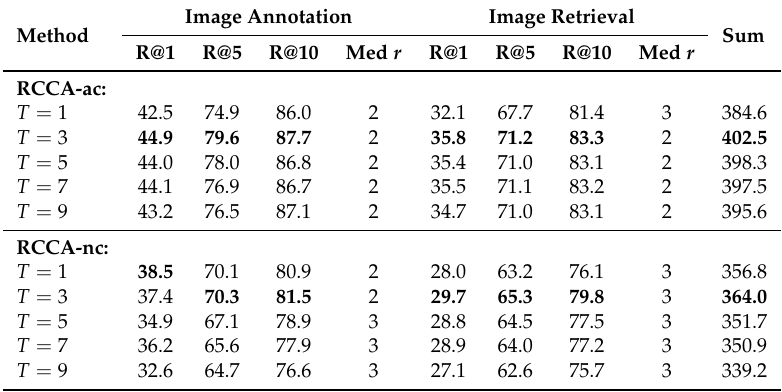
Table 4. Different numbers of time steps on the Microsoft COCO dataset. T : number of time steps in contextual attention-based